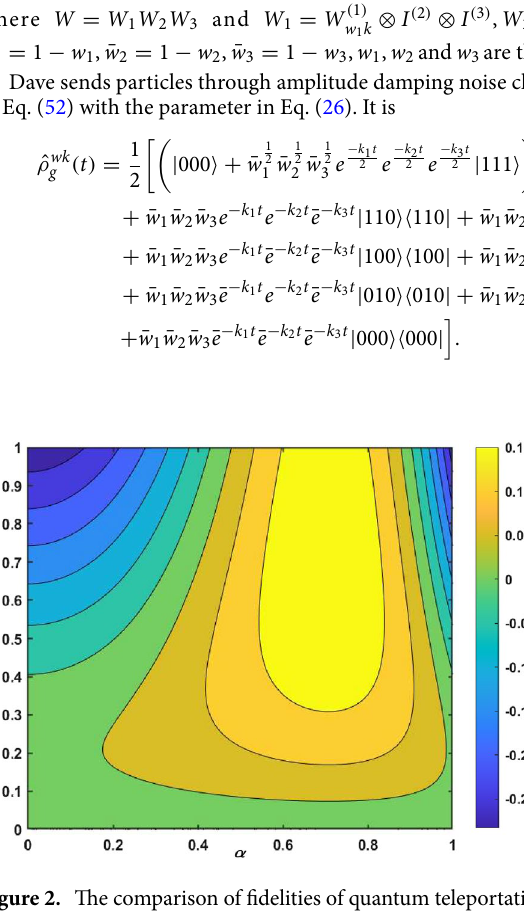
Figure 2. The comparison of fidelities of quantum teleportation between GHZ state and W 1 state. Considering the noise parameters of GHZ and W 1 both are k 1 = k 2 = k 3 = k